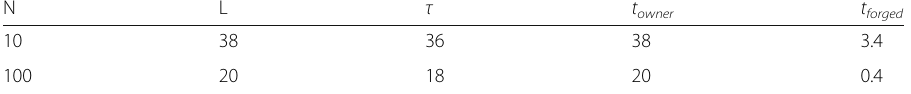
Table 2 Watermark verification results of owner ’ s legal trigger set and attacker ’ s forged trigger set